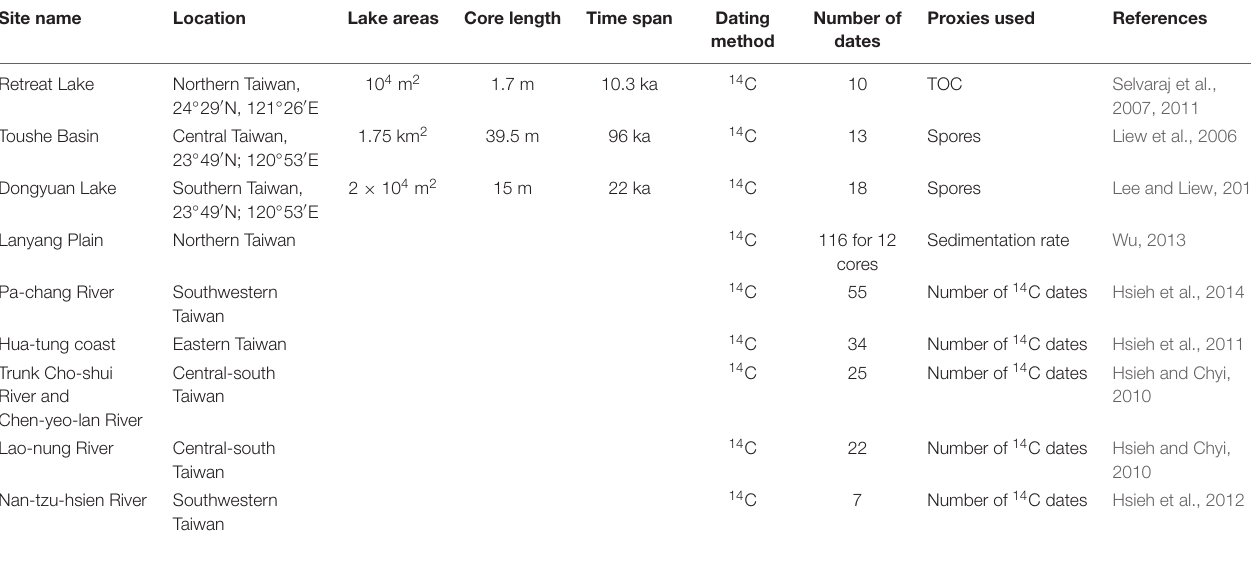
TABLE 1 | Paleoclimate records from Taiwan synthesized in this